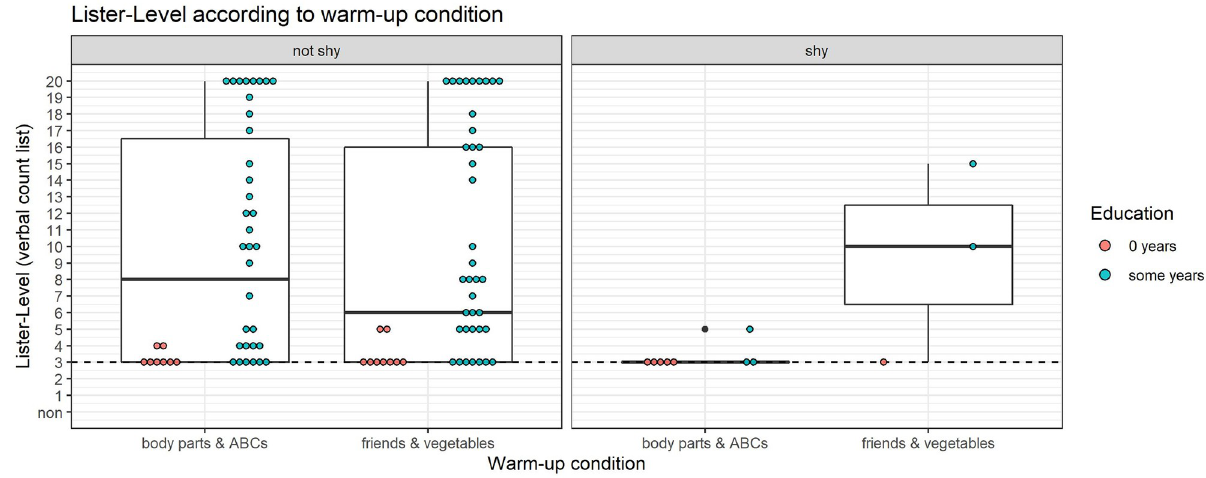
Fig 3. Count list items listed per warm-up condition. How many items of the verbal count list were named under each different warm-up condition. The plot is divided into two panels, the rightmost representing children who are shy (the minority). Children with zero years reported formal education (red dots) have lower Lister-Levels than children with some formal education (teal